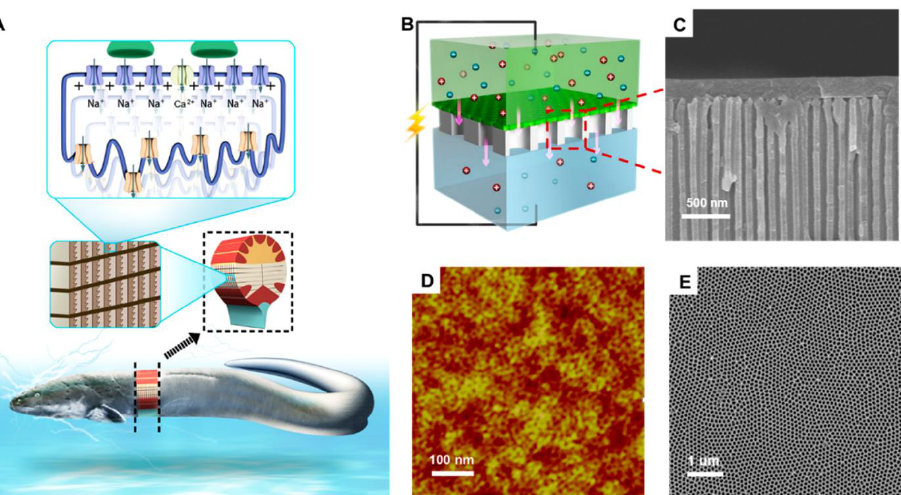
Figure 18. Bioinspired membrane for energy conversion. ( A ) Illustration demonstrating structure of electric eel skin with schematic display of ion channels, ( B ) schematic of bioinspired membrane for energy conversion, ( C ) SEM cross-section of the device, ( D ) AFM and ( E ) SEM top view of NAA membrane. Reprinted with permission from [241]. Copyright 2018 American Chemical